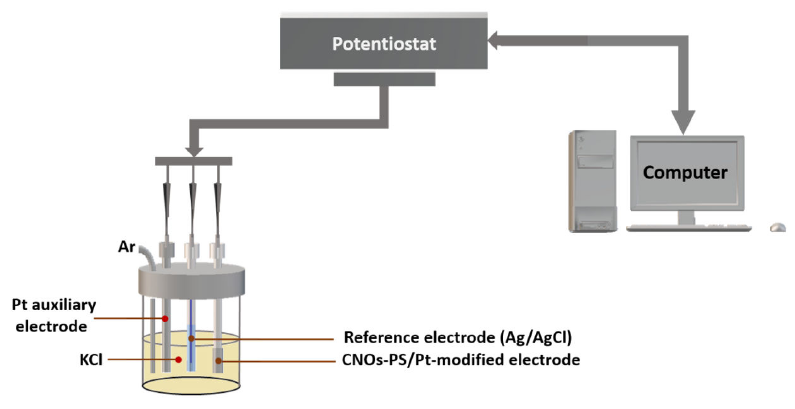
Figure 1. Experimental setup to detect Cys and Met.